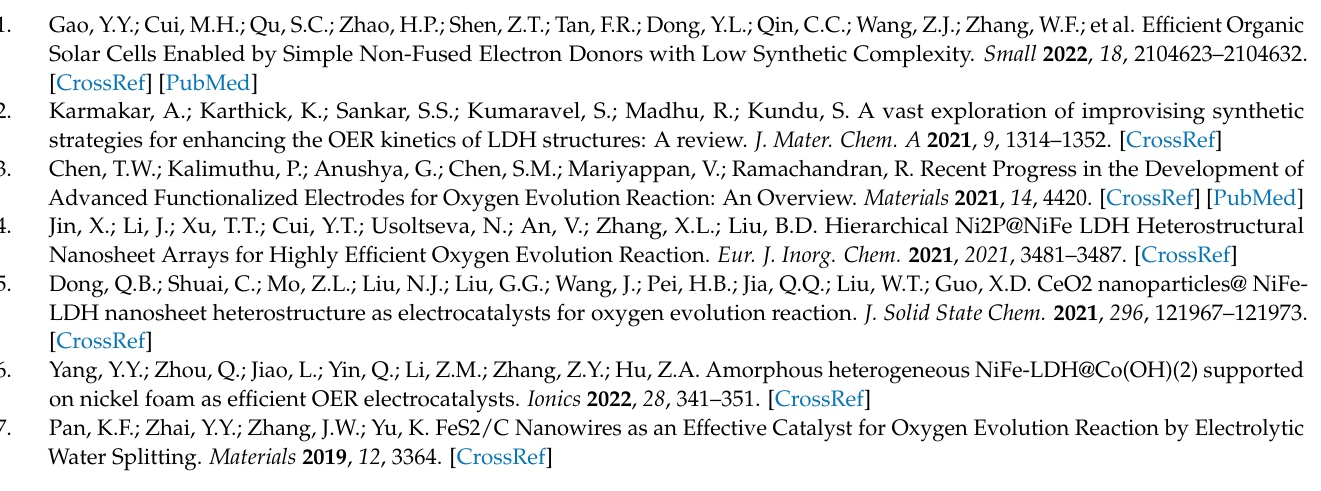
Figure S5. XPS survey spectrum of CoFe-LDH@Co-ZIF@CC. Figure S6. XPS C 1s spectrum of